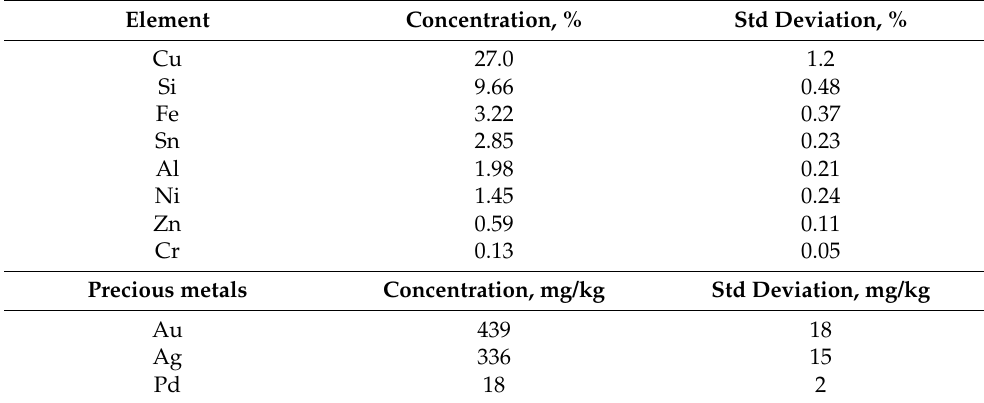
Table 4. Chemical composition of PCBs mobile phones ( − 0.5 mm) determined by atomic absorption spectroscopy (AAS). Averages of six